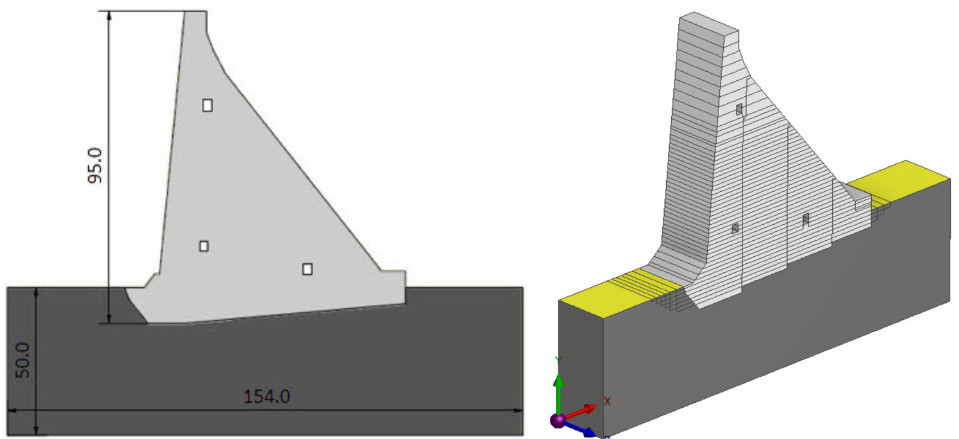
Figure 3. ( Left ): Characteristic cross-section; ( right ): 3D model of the monolith with 78 blocks and the surrounding rock mass for thermal stress